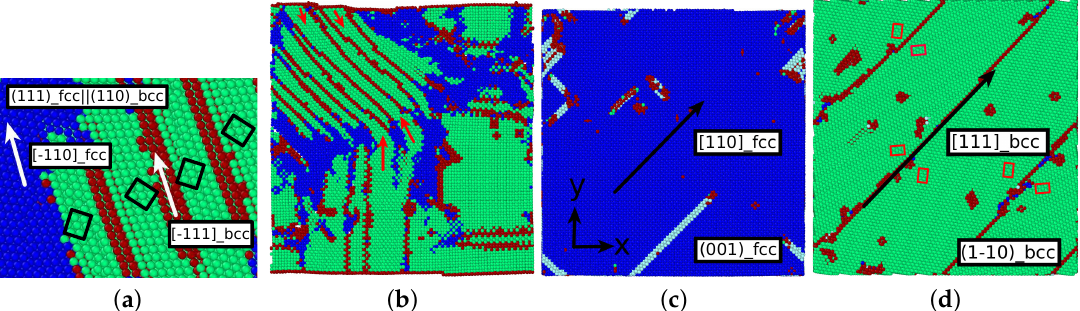
Figure 9. Pathway during the martensitic transformation of a sample with a dislocation density of 10.34 × 10 12 cm − 2 ; cf. Figure 8. ( a ): View on the close-packed plane ( 111 ) fcc (cid:107) ( 110 ) bcc during the phase transition; the figure shows a detail in the nanotwinned structure in the top left part of Figure 8e. The white arrows denote the conserved directions, [ ¯110 ] fcc (cid:107) [ ¯111 ] bcc ; the black rectangles highlight the twin structure; ( b ) view on the x – z plane displaying a transformation state between Figure 8e,f; the red arrows emphasize the connection between the global phase nucleating at the surface and the nanotwinned structure; snapshots ( c , d ) compare the structures before ( c ) and after ( d ) the transformation by providing a view on a ( 001 ) fcc (cid:107) ( 1¯10 ) bcc plane. Arrows indicate the conserved direction, [ 110 ] fcc (cid:107) [ 111 ] bcc . Red rectangles in ( c ) highlight the twin structure built around the twin ( 11¯2 ) bcc boundaries. The colors denote the local lattice structure as in Figure